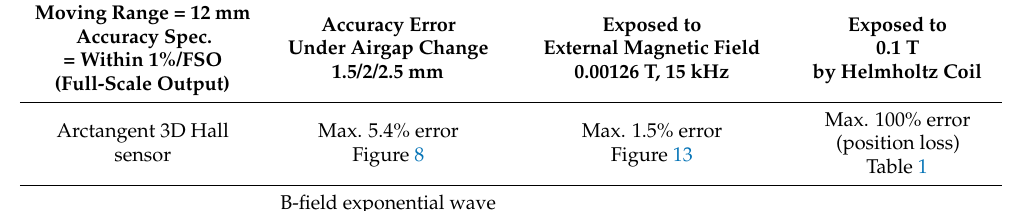
Table 2. Comparison of 3D Hall sensor to proposed IPS. Moving Range = 12 mm Accuracy